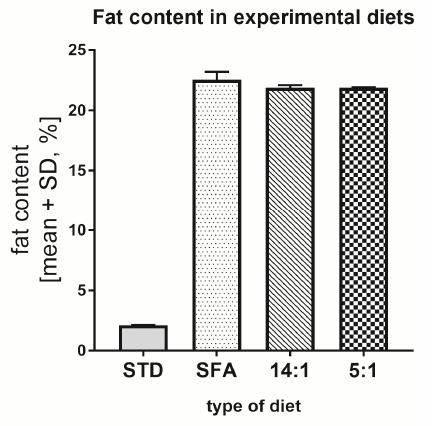
Figure 1. Amount of total fat content in the experimental diets.